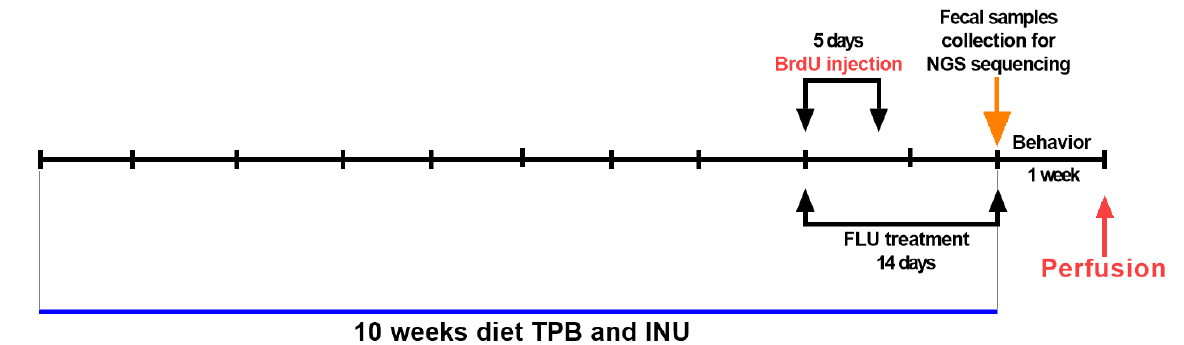
Figure 1. Schematic illustration of the experimental design.